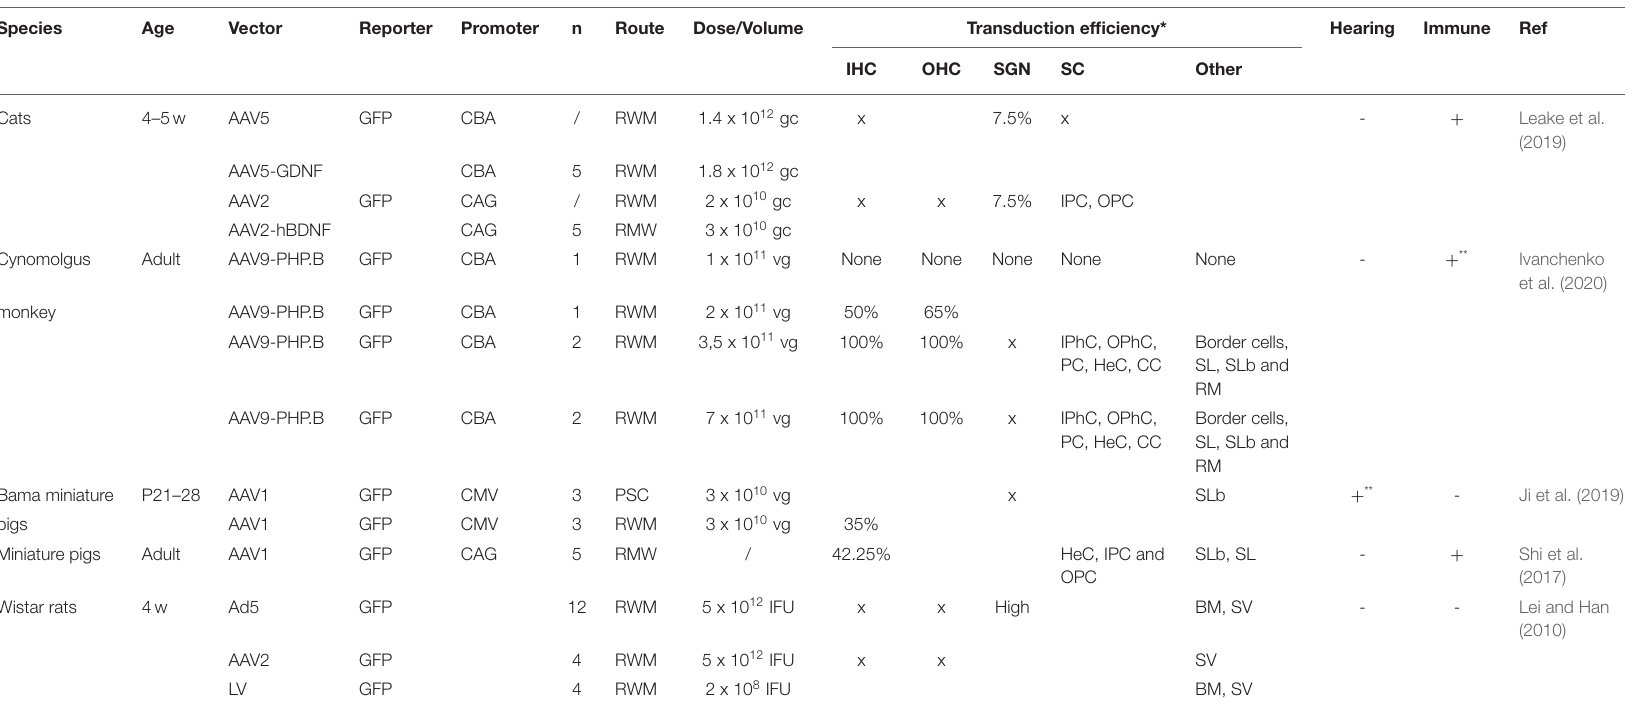
TABLE 3 | Summary of extracted data from gene therapy studies performed in other species. Species